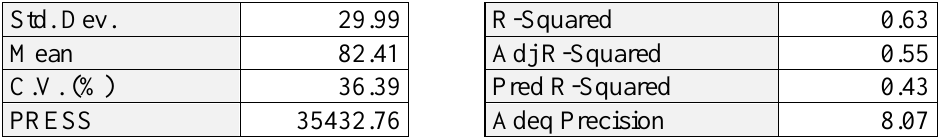
Table 4 – Characteristics for model (Myers, Montgomery and Anderson-Cook, 2009) Std. Dev. 29.99 R-Squared Mean C.V. (%) PRESS 8.07 The contour graph contains, just like a geographical map, lines which link the points in the domain of the function that give the same value of the output Y . A second regression model was also found for logS 2 . It takes the form (its graph is in Figure